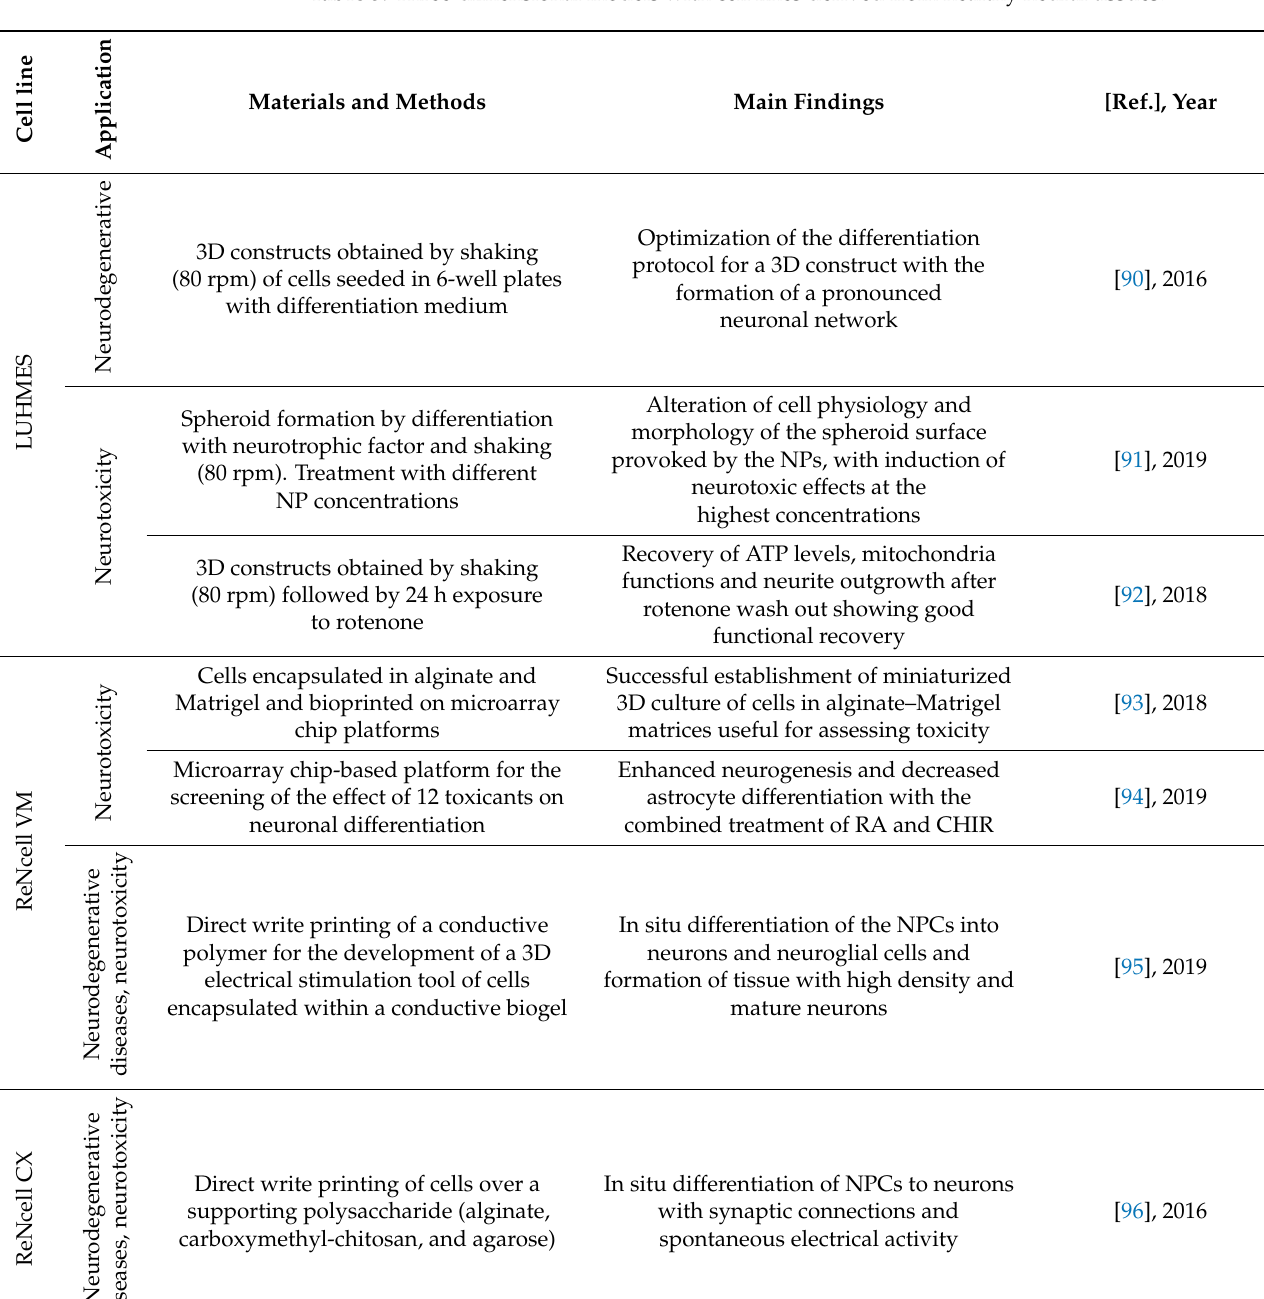
Table 5. Three-dimensional models with cell lines derived from healthy neural